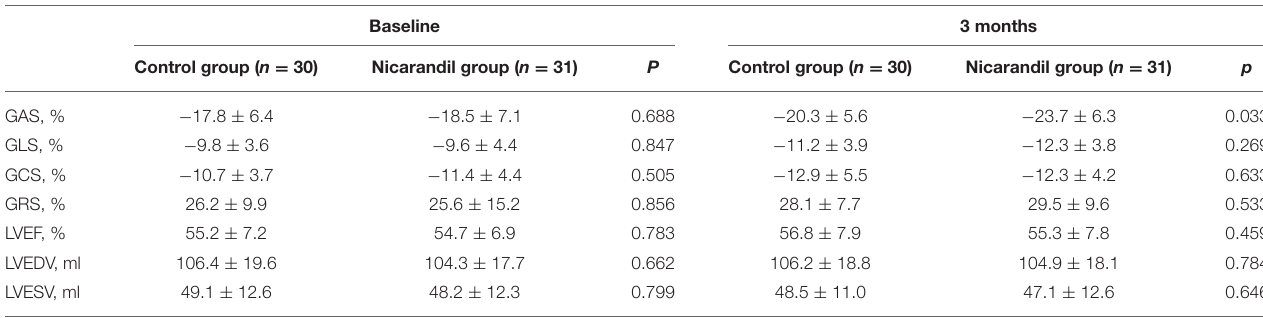
TABLE 3 | 3D echocardiographic data of the nicorandil group and the control